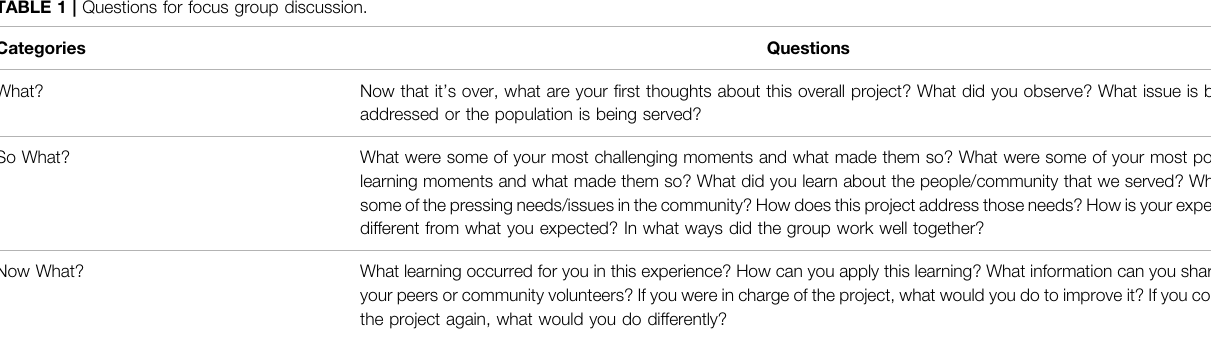
TABLE 1 | Questions for focus group discussion.